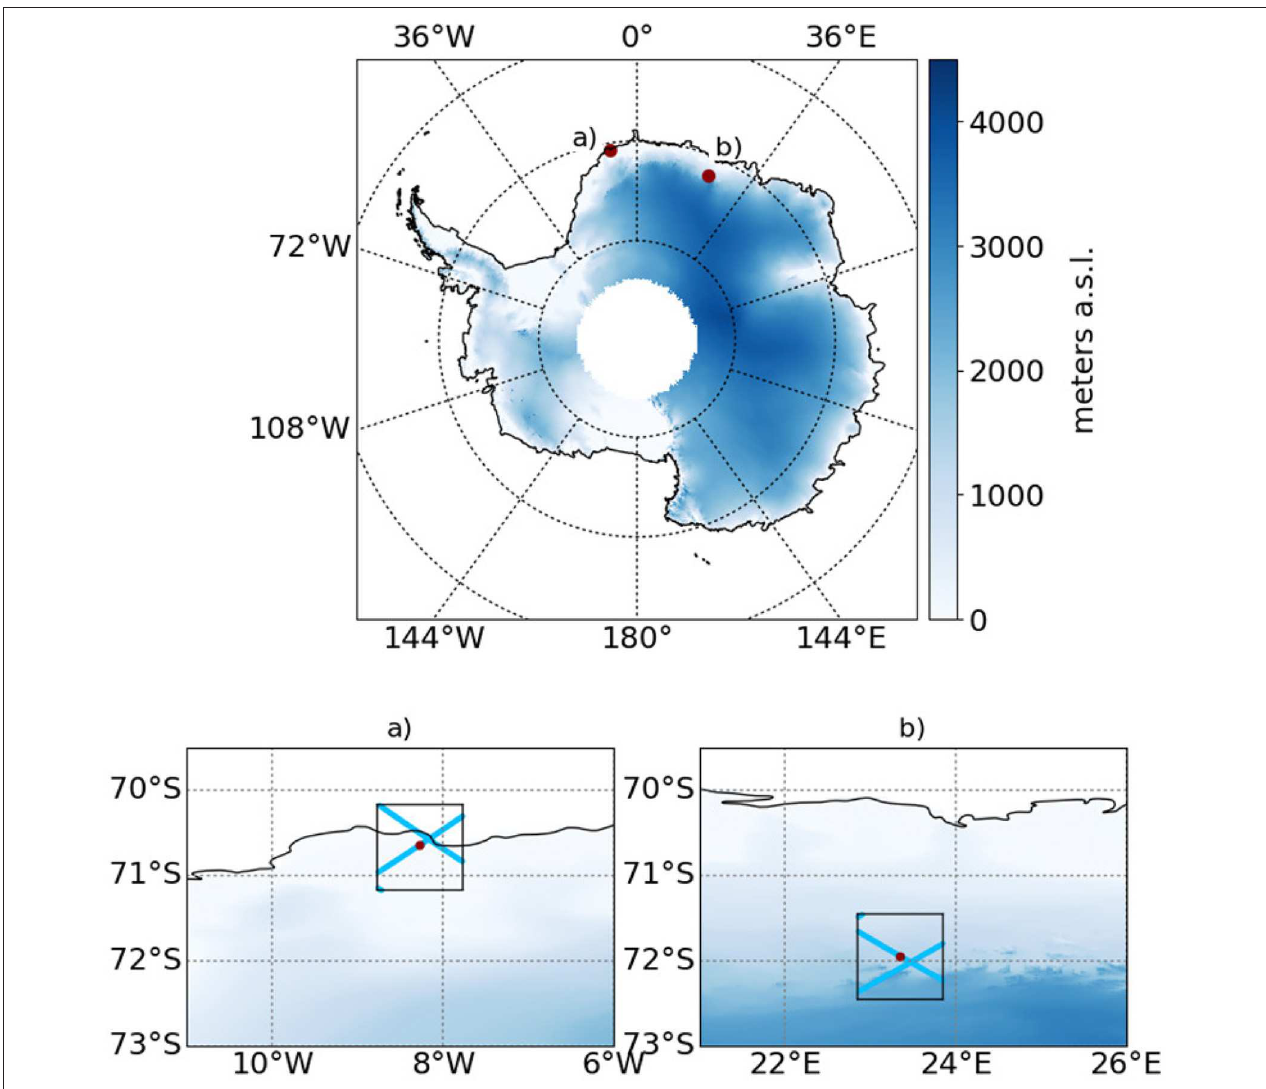
FIGURE 1 | Location of the two Antarctic stations used in this study. Top : The Antarctic continent, the red dots indicate the location of the stations. Elevation is represented in blue. Bottom : zoom over (a) the Neumayer and (b) Princess Elisabeth stations. The gray boxes represent the 1 × 1 ◦ area. Elevation is represented in blue and the satellite track is represented by the light blue